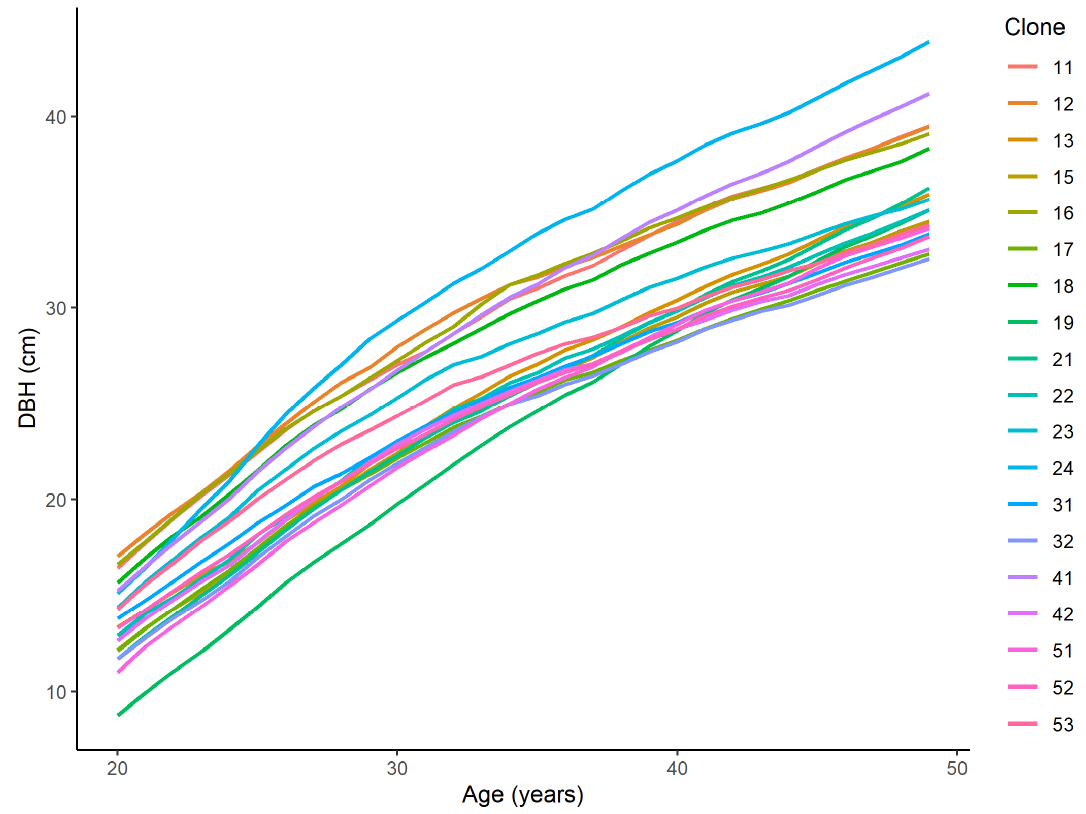
Figure 1. The mean diameter growth trajectories of the 19 Norway spruce clones that were analysed in this study.